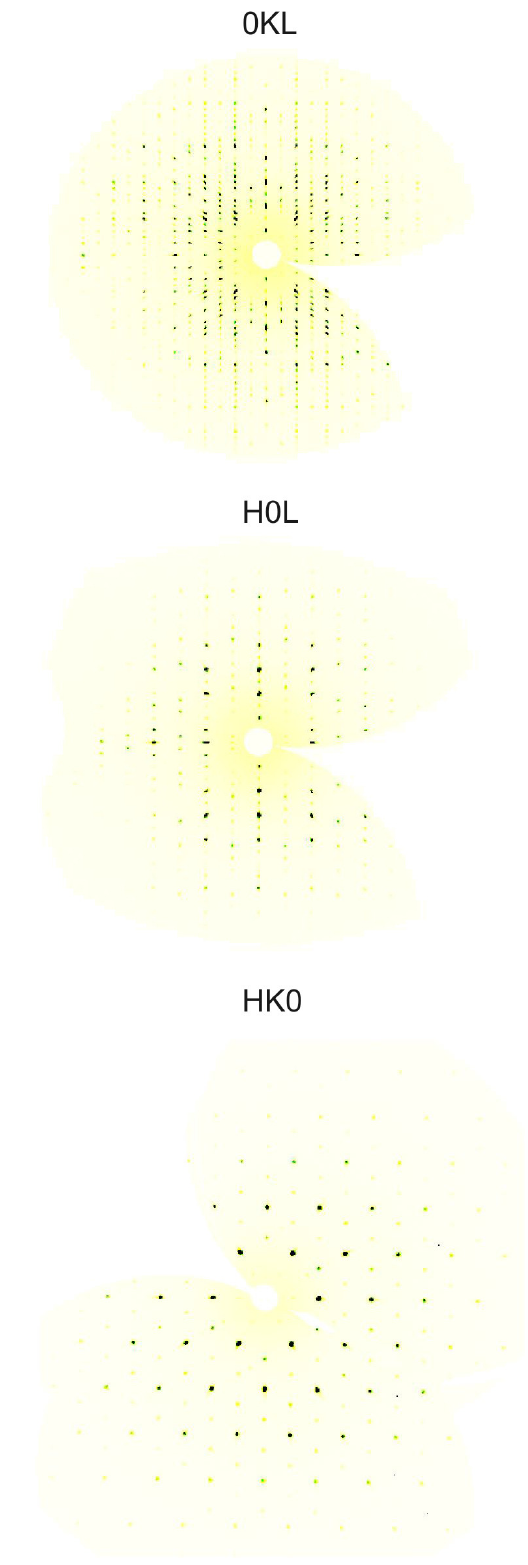
Figure 3. Single crystal X-ray diffraction intensities of Ba 26 Ru 12 O 57 within the 0 KL , H 0 L and HK 0 planes of reciprocal space (space group I4/mmm